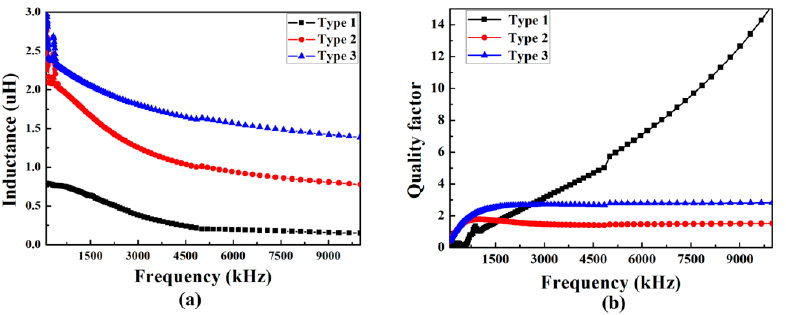
Figure 11. Measured inductances and quality factors of three planar inductors. ( a ) Inductance L as a function of frequency; ( b ) quality factor Q as a function of frequency.